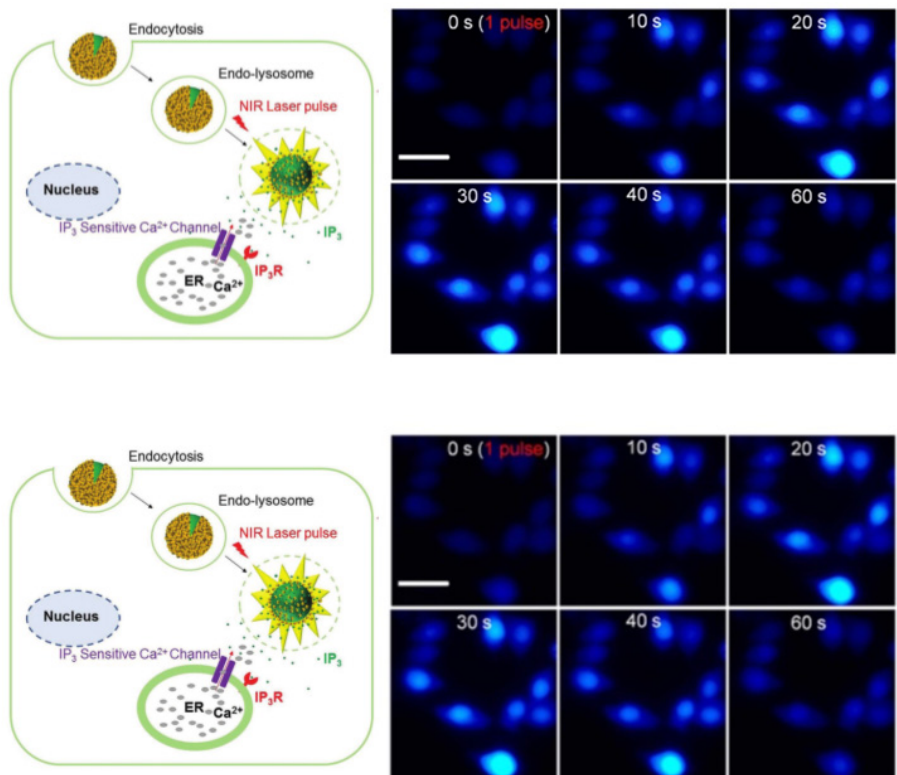
Figure 17. ( Left ): Schematic of gold-coated liposomes containing IP 3 entering the cell via endocytosis. A single laser pulse induces vapor nanobubbles that rupture the liposome- and endosome-releasing IP 3 to the cytoplasm. The IP 3 opens calcium channels, thereby increasing the calcium concentration in the cytoplasm detected by the Fluo-4 calcium indicator. ( Right ): Time sequence of Fluo-4 fluorescence in RAW 264.7 cells following NIR light-induced rupture of IP 3 -containing liposomes trapped in endosomes. The blue fluorescence signal within each cell increases up to about 30 sec, indicating release of calcium from the ER. Bar is 10 µ m, and the magnification is the same in all images. Adapted from [46,47], published by Wiley, 2017 and Wiley, 2020.